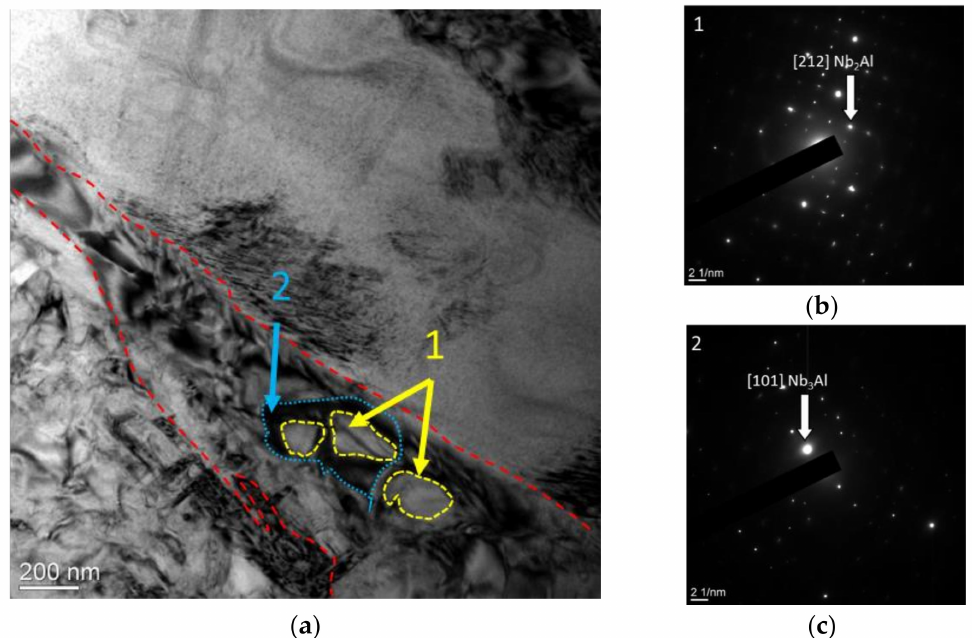
Figure 6. Fine structure of the Ti-25Al25Nb at.% system alloy: ( a ) bright field; ( b , c ) electron diffraction pattern from selected